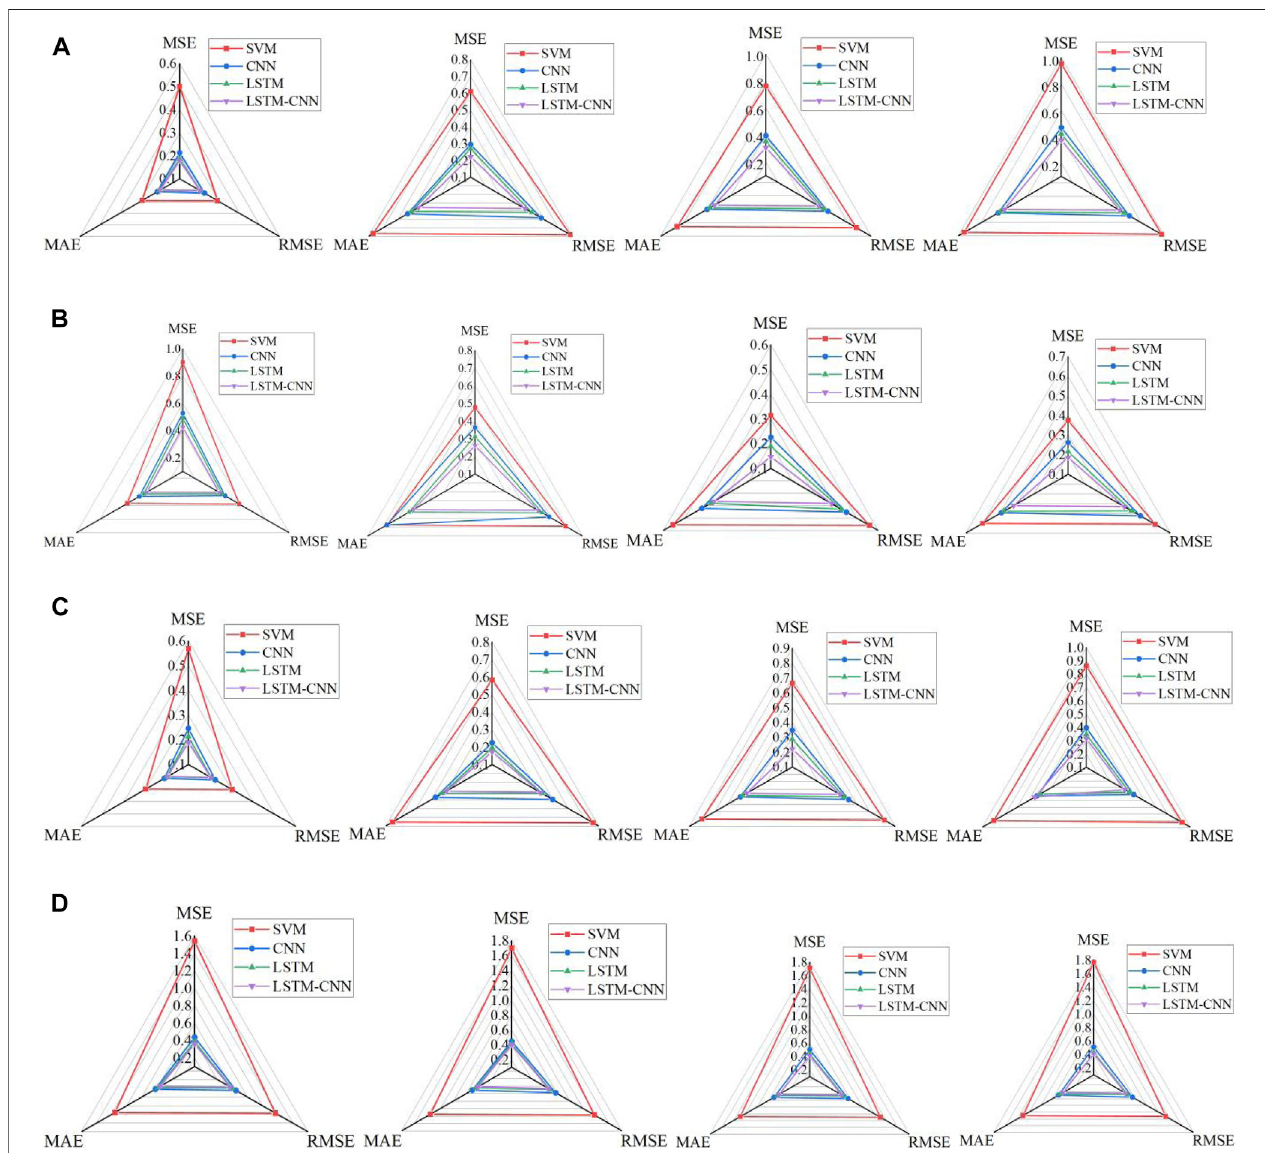
FIGURE 4 | Prediction results for the four wind turbines under different prediction steps: (A) step (cid:2) 1; (B) step (cid:2) 2; (C) step (cid:2) 3; (D) step (cid:2) 4.